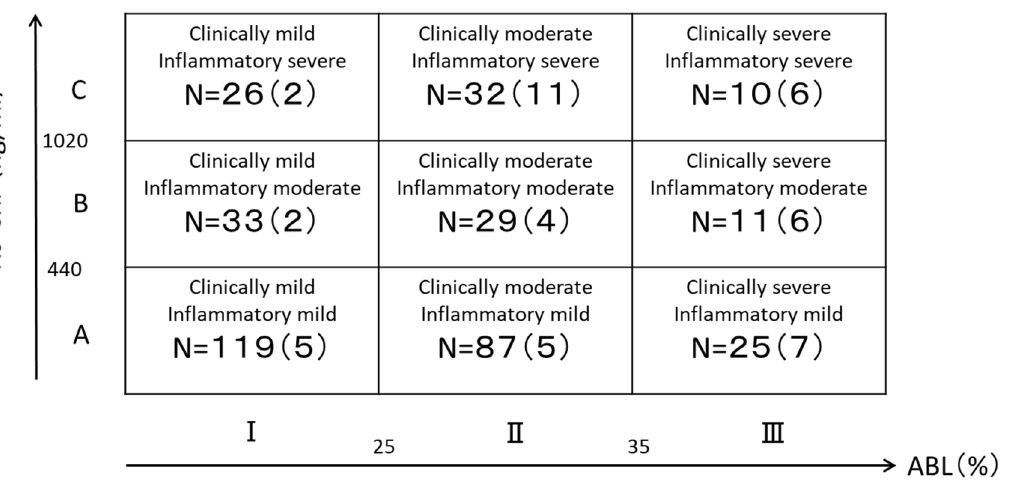
Figure 1. Number of subjects according to classification of periodontal disease severity. ( ): number of patients with type 2 diabetes